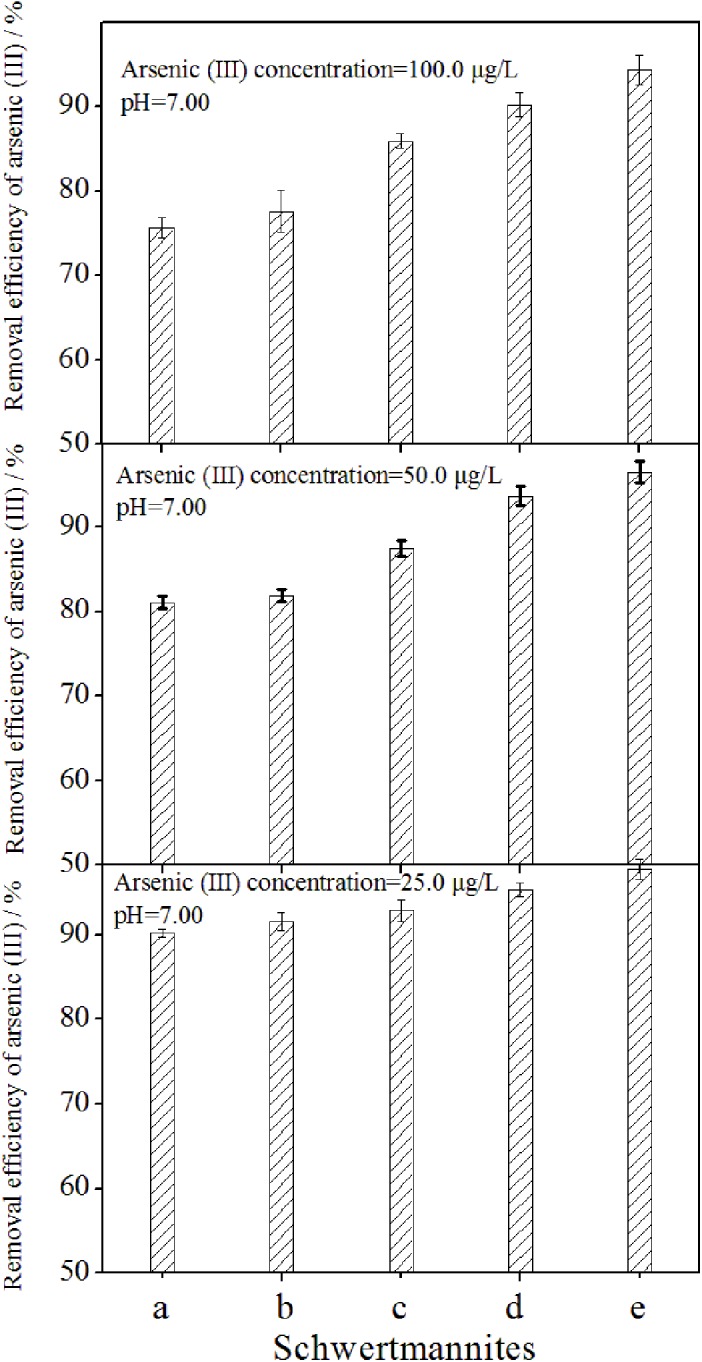
Removal efficiency for different concentrations of arsenic (III) in the solution over 0.25 g/L schwertmannite harvested from different chemical synthesis systems.150 mL of FeSO4·7H2O solution with addition of a: 1.80 mL of H2O2 at 2 h (treatment 1); b: 0.90 mL of H2O2 at 2 and 14 h (treatment 2); c: 0.60 mL of H2O2 at 2, 14, and 26 h (treatment 3); d: 0.45 mL of H2O2 at 2, 14, 26, and 38 h (treatment 4); and e: 0.36 mL of H2O2 at 2, 14, 26, 38, and 50 h (treatment 5); volume concentration of H2O2: 30%; molar concentration of FeSO4·7H2O: 160 mmol/L.